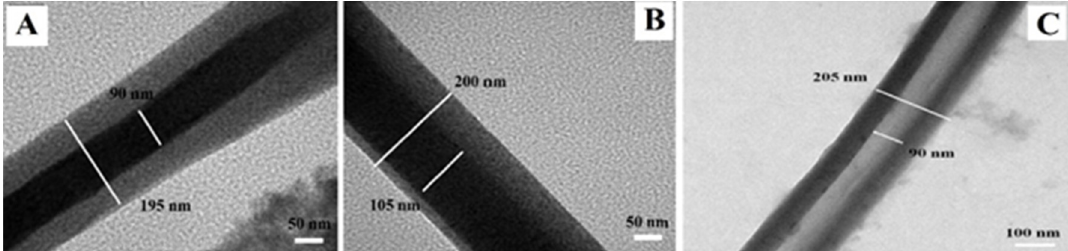
Figure 11. TEM images of PEO-chitosan biocomponent electrospun fibers showing ( A ) concentric core-shell structure, ( B ) eccentric core-shell structure, and ( C ) hollow chitosan shell structure [75]. (Reprinted with permission from Pakravan et al., 2012.)